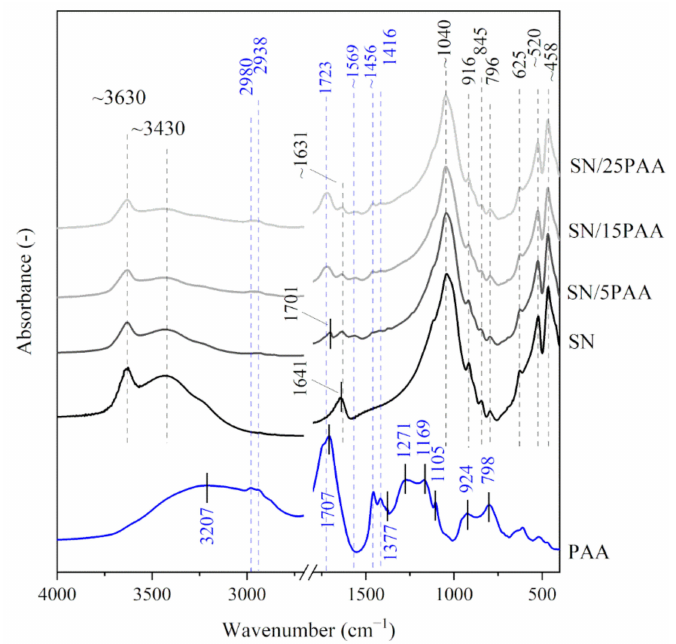
Figure 1. IR spectra of starting materials SN and PAA used in the preparation of composite materials with different polymer contents: SN/5PAA, SN/15PAA,